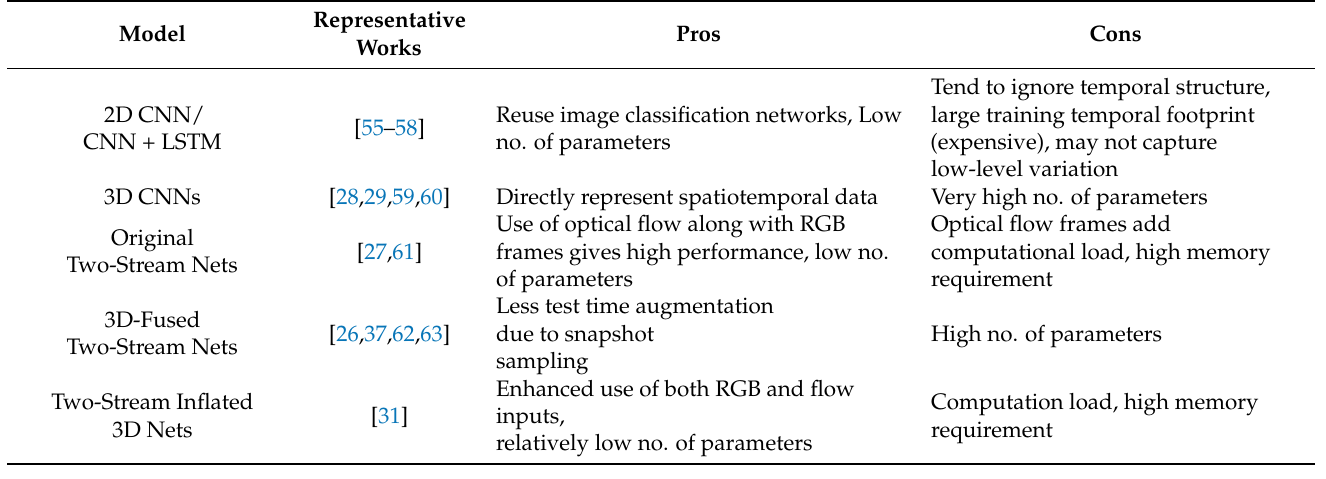
Table 1. Comparison of Video Representation Architecture Models.